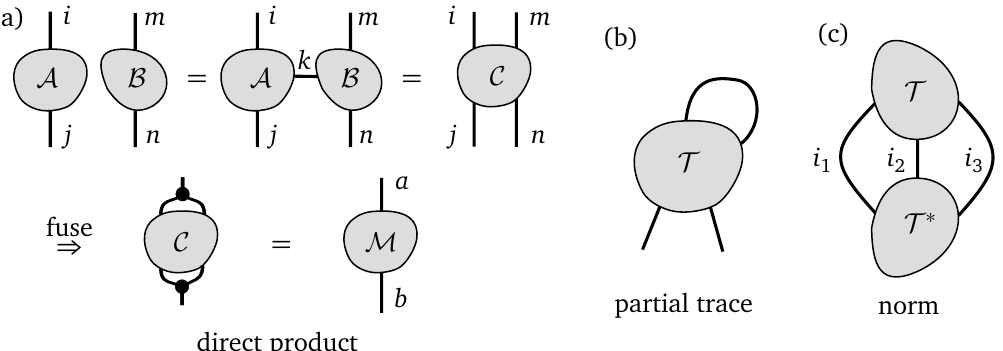
Figure 8: Variants of contractions. (a) Direct product of two matrices, or two-link tensors A and B . By attaching a one-dimensional “dummy” link to both tensors, ij mn = A · B we can indicate the contraction C . Formally, a subsequent (column- ijmn ij mn = C major, Eq. (8)) fusion over the permuted link-bipartition M ( mi )( nj ) gives us the ab Kronecker product M = A ⊗ B . (b) The partial trace. (c) The Hilbert–Schmidt norm obtained by full contraction with the complex conjugate T ∗